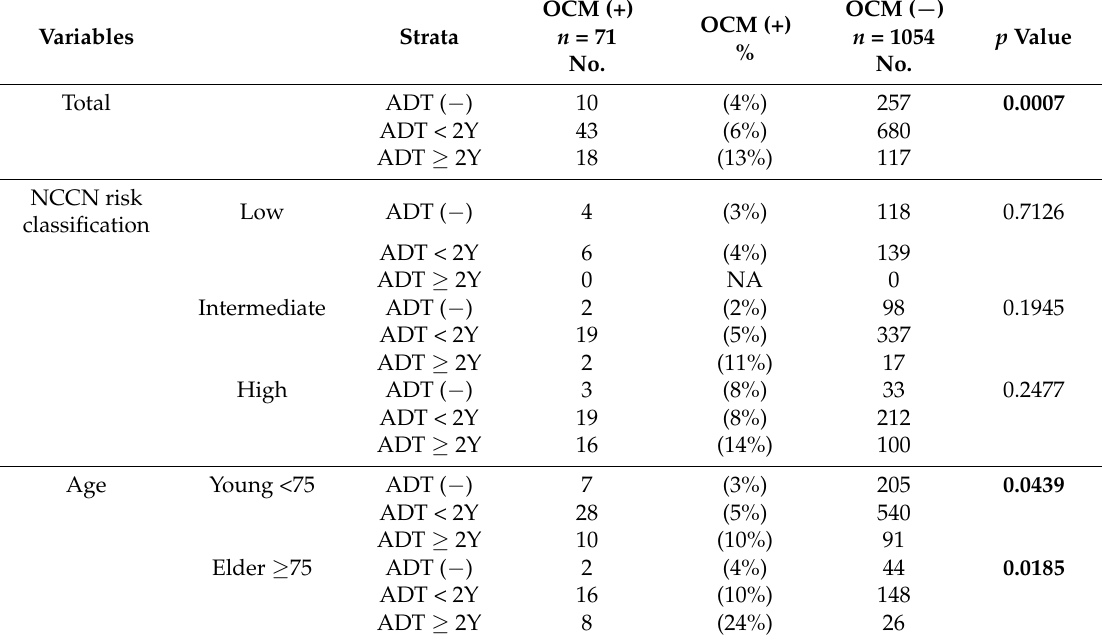
Table 4. Characteristics and treatment factors of patients with other cause of mortality (OCM) according to duration of